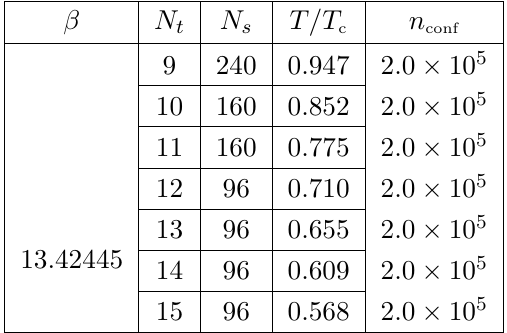
Table 6 . Information on the simulations at β = 13 . 42445